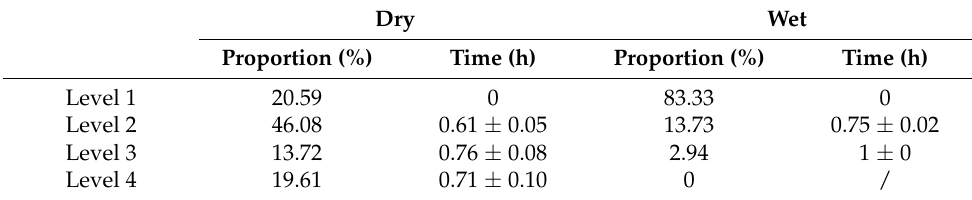
Table 1. Comfort questionnaire results.